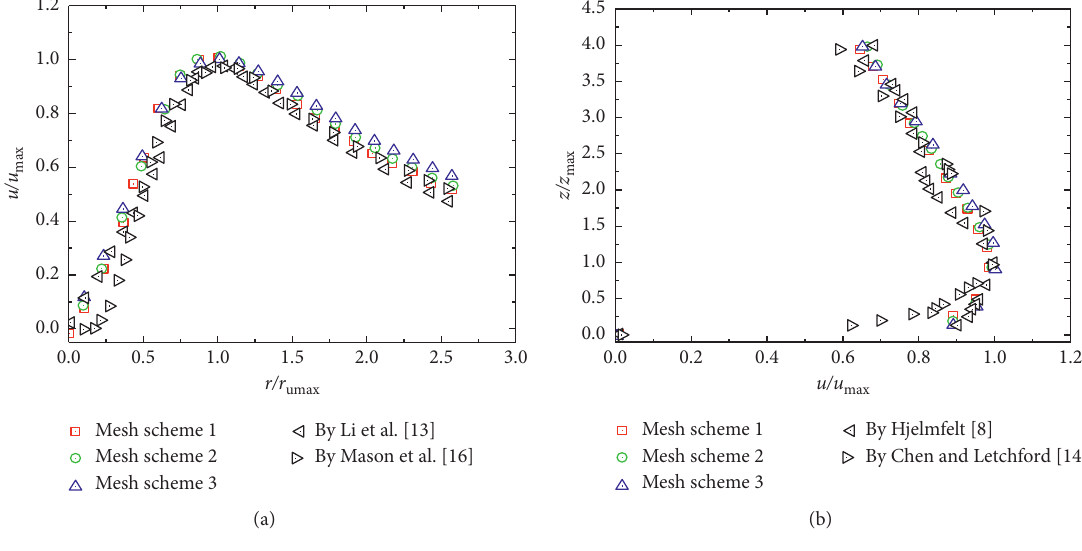
Figure 2: Comparisons of (a) radial and (b) vertical profiles of horizontal wind speed.